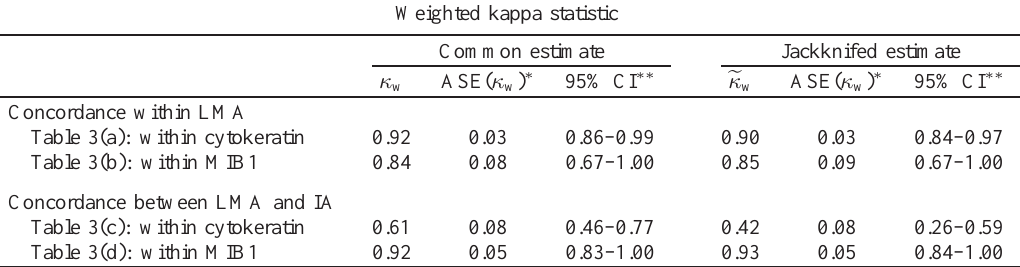
Table 4 Weighted kappa statistic Common estimate